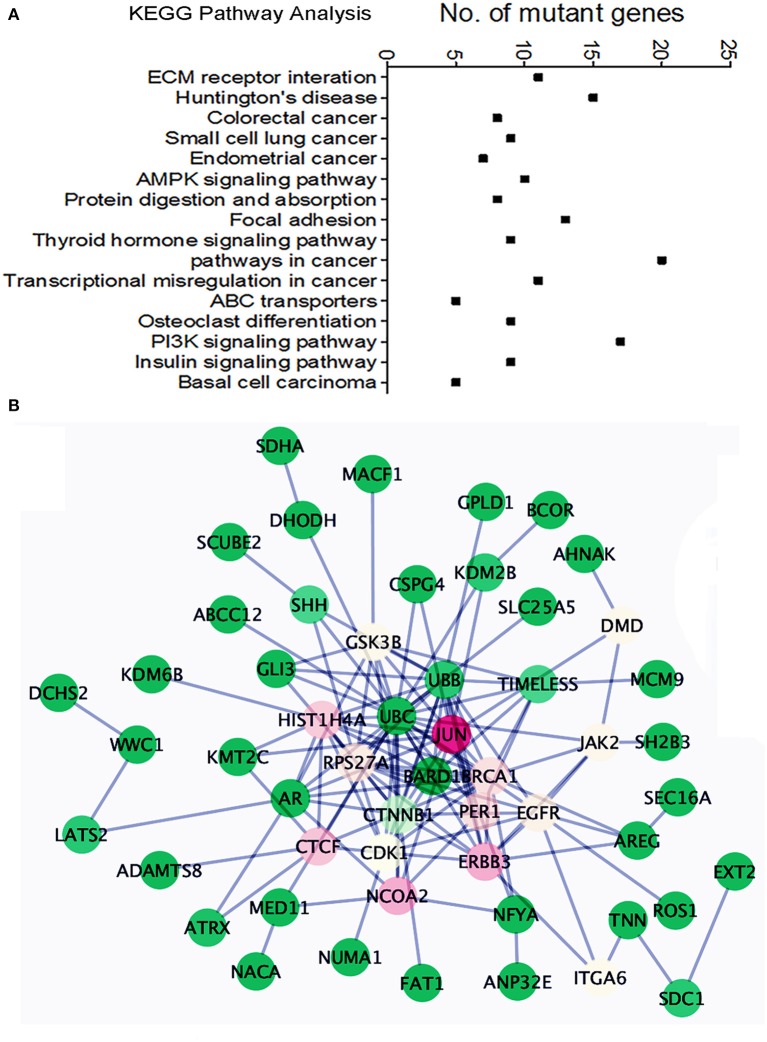
Pathway analysis of the frequently mutated genes in Mullerian adenosarcoma (MAS). (A) Dot plot illustrates KEGG pathway analysis of oncogenes/tumor suppressor genes altered in MAS (for details, see text). (B) Schematic diagram illustrates the functional connections among 43 mutated genes. The color indicated the value of Betweenness Centrality (green = minimum, red = maximum).